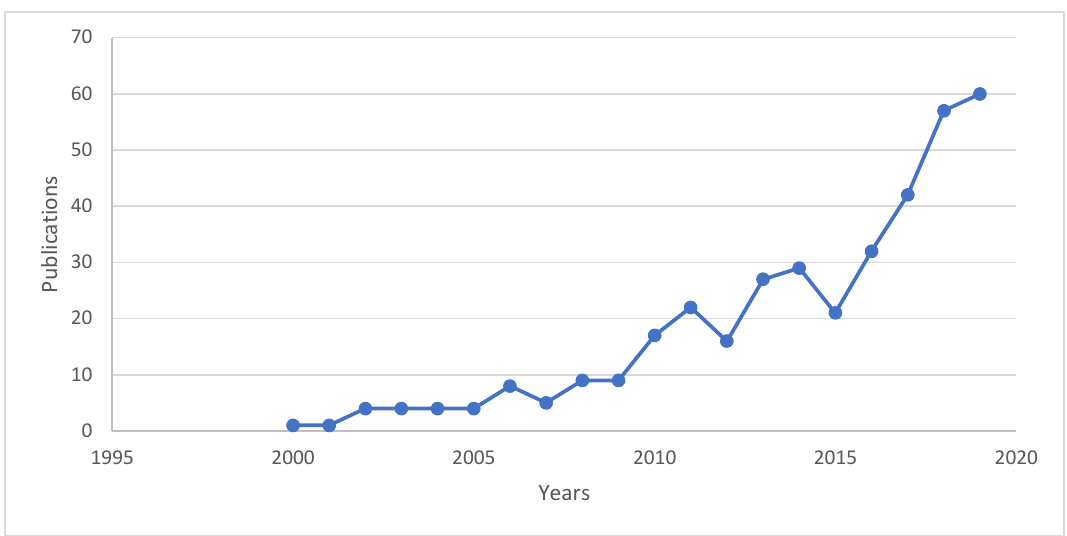
Figure 1. The trend research on starch based composite reinforced essential oil as biopolymer (SCOPUS, August 2020, Keywords: starch, essential oil).